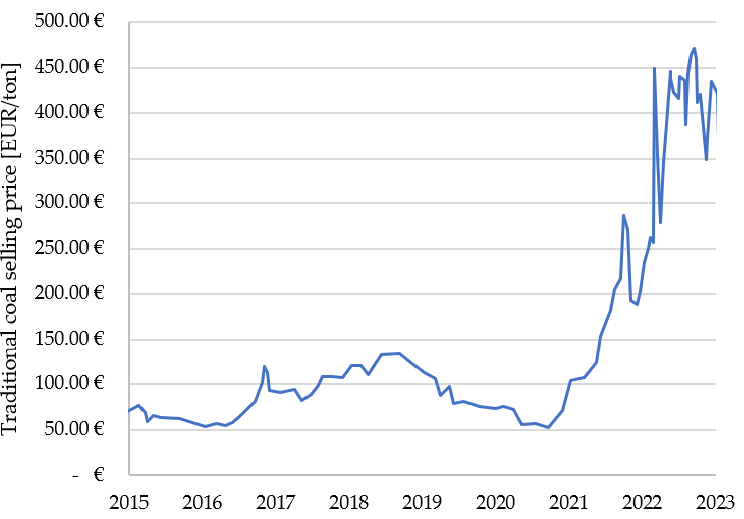
Figure 4. Trend of traditional coal selling price since 2015.